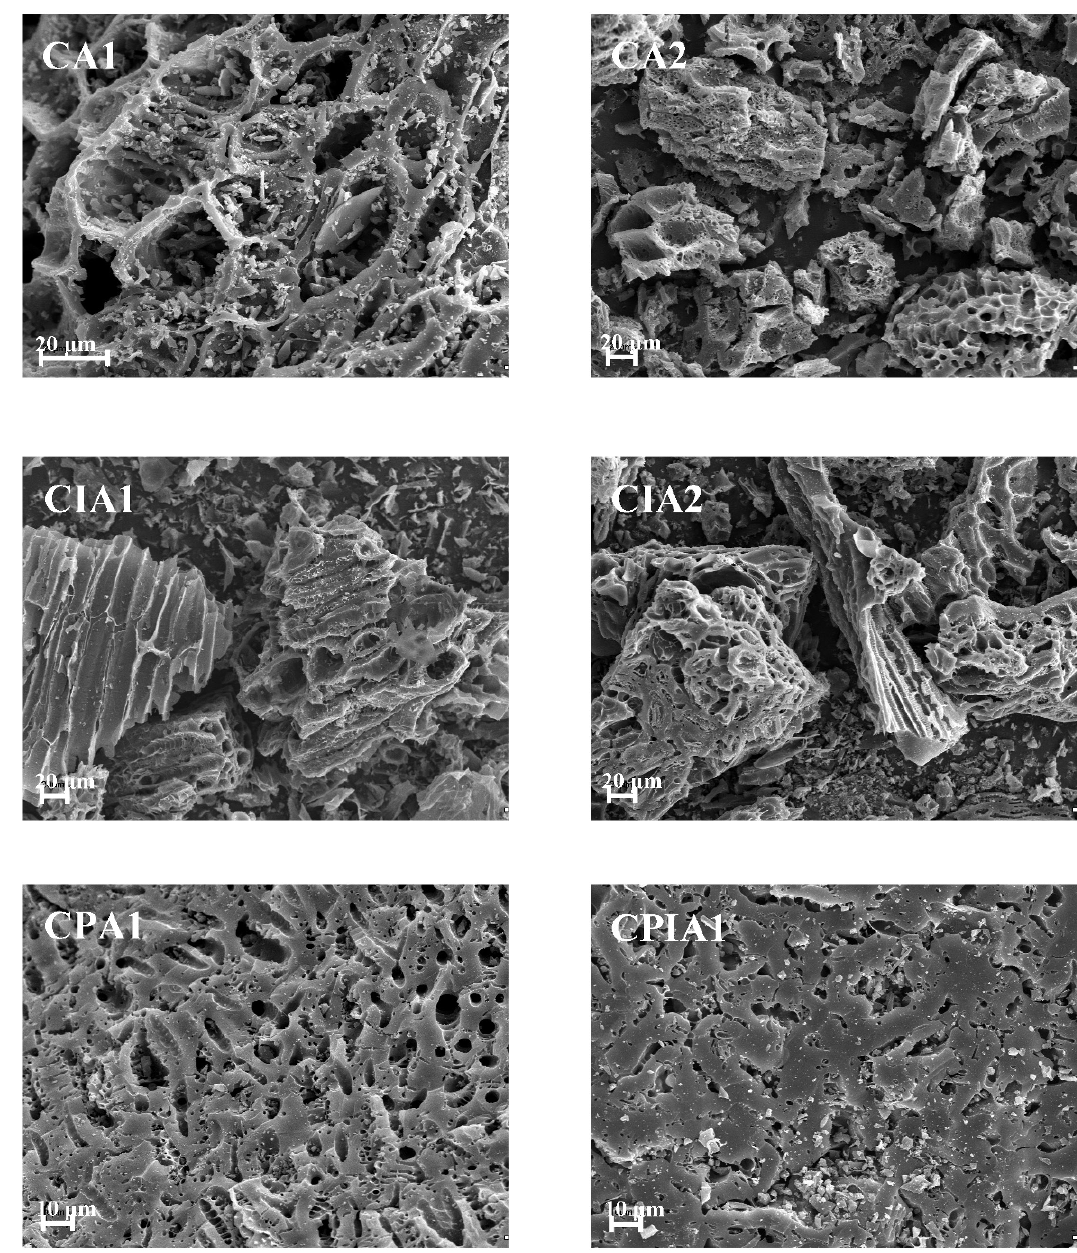
Figure 2. SEM images of the activated carbon samples